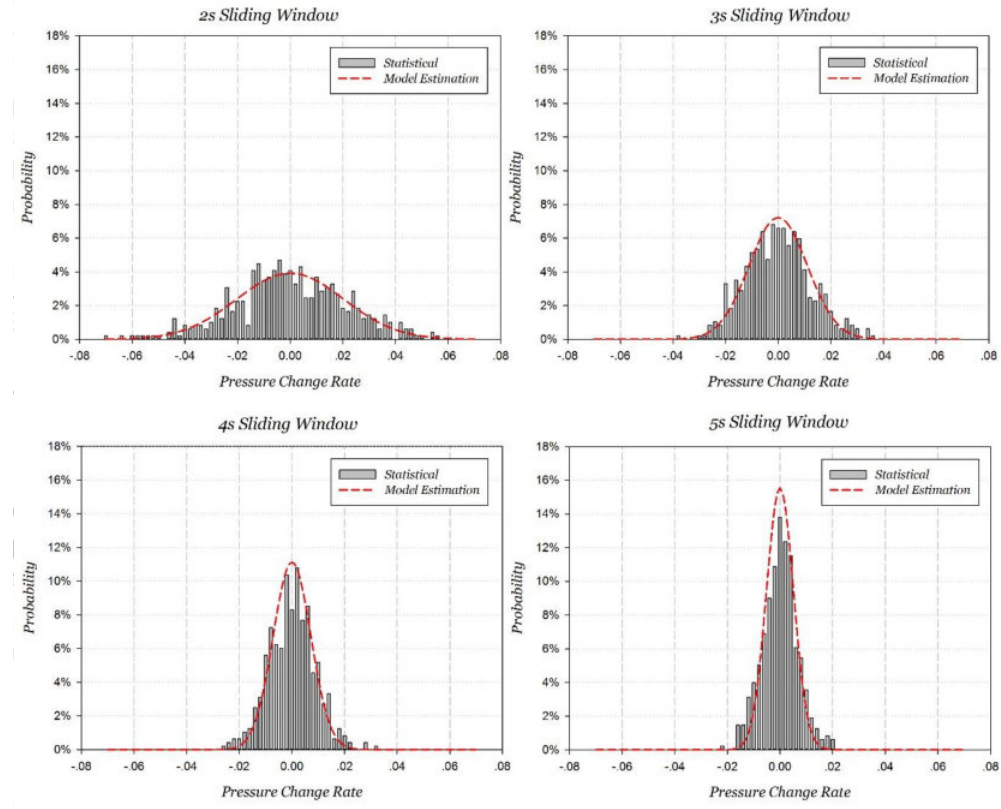
Figure 10. Statistical PCR probability distribution and model estimation at static with different lengths of sliding